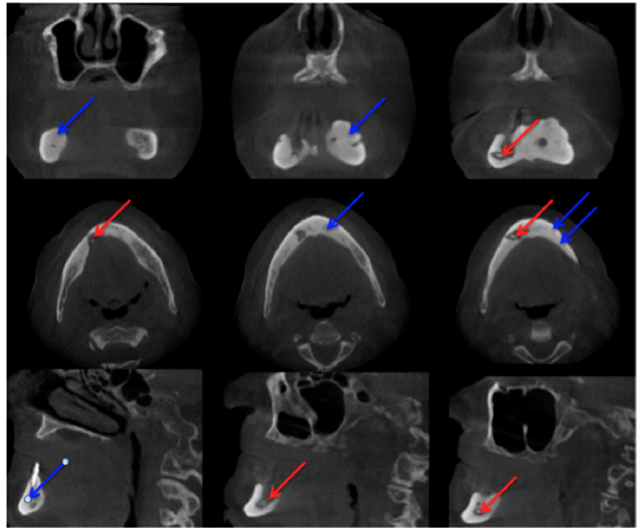
Figure 4. Cone-beam computed tomography (Carestream CS 9300) Patient: 77 years old, metastatic prostate cancer, ibandronic acid and later another antiresorptive drug: denosumab. For panoramic radiograph see Figure 2. 1st row: coronary view; 2nd row: axial view; and 3rd row: sagittal view. Red arrows: sequester; blue arrows: sclerotic region. AAMOS staging: stage 2.